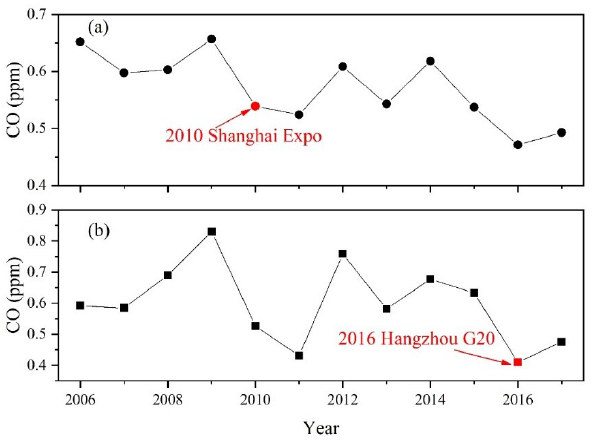
Figure 9. Average CO levels for the periods corresponding to (a) the 2010 Shanghai Expo (from 1 May to 31 October) and (b) 2016 Hangzhou G20 (from 24 July to 6